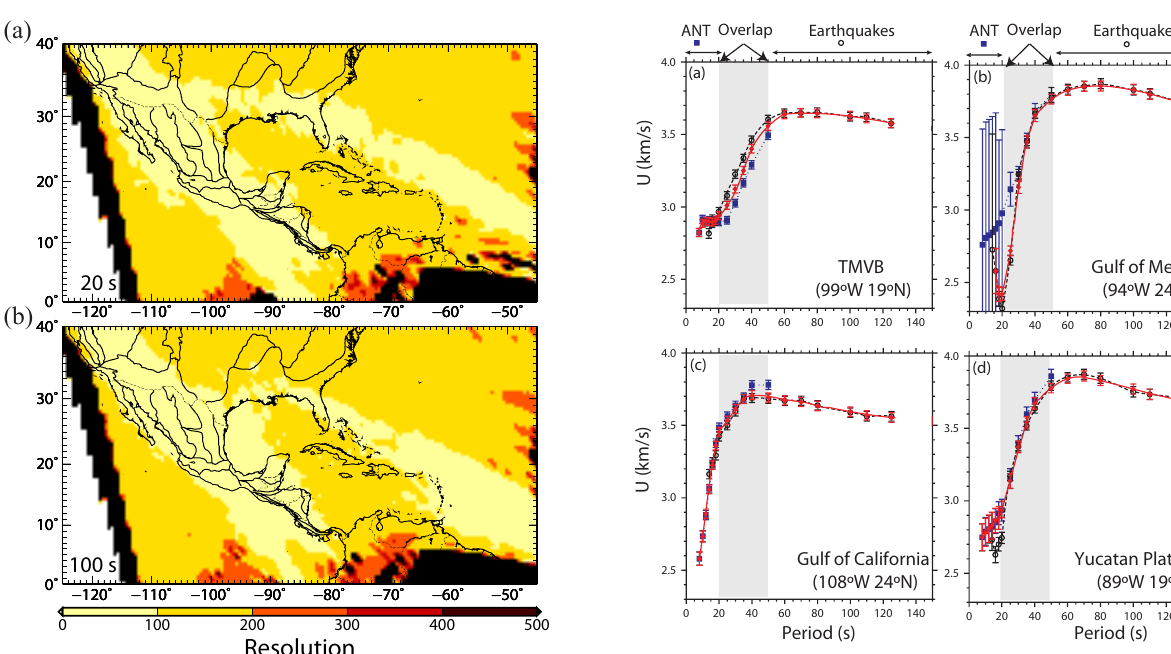
Figure 4. Estimated resolution in km for group velocity maps at (a) 20s and (b) 100s period.